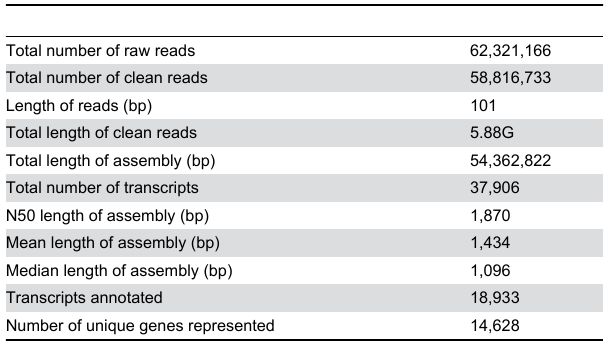
Table 1. Summary of transcriptome data for